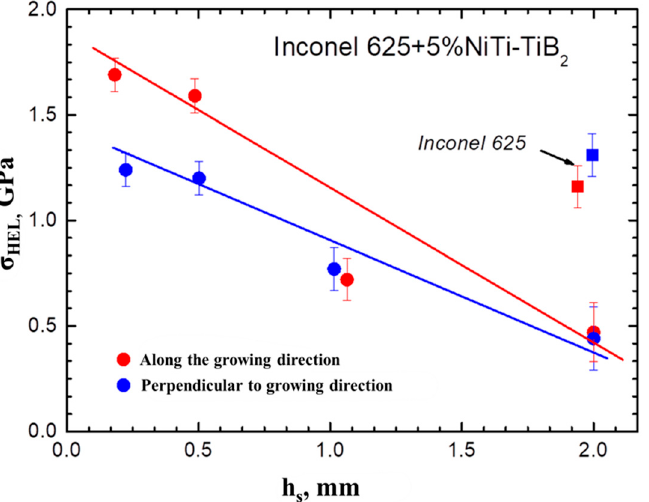
Figure 5. Hugoniot elastic limit of the 95% Inconel 625 + 5%NiTi–TiB 2 AM alloy. The data for pure Inconel 625 alloy were taken from [27].